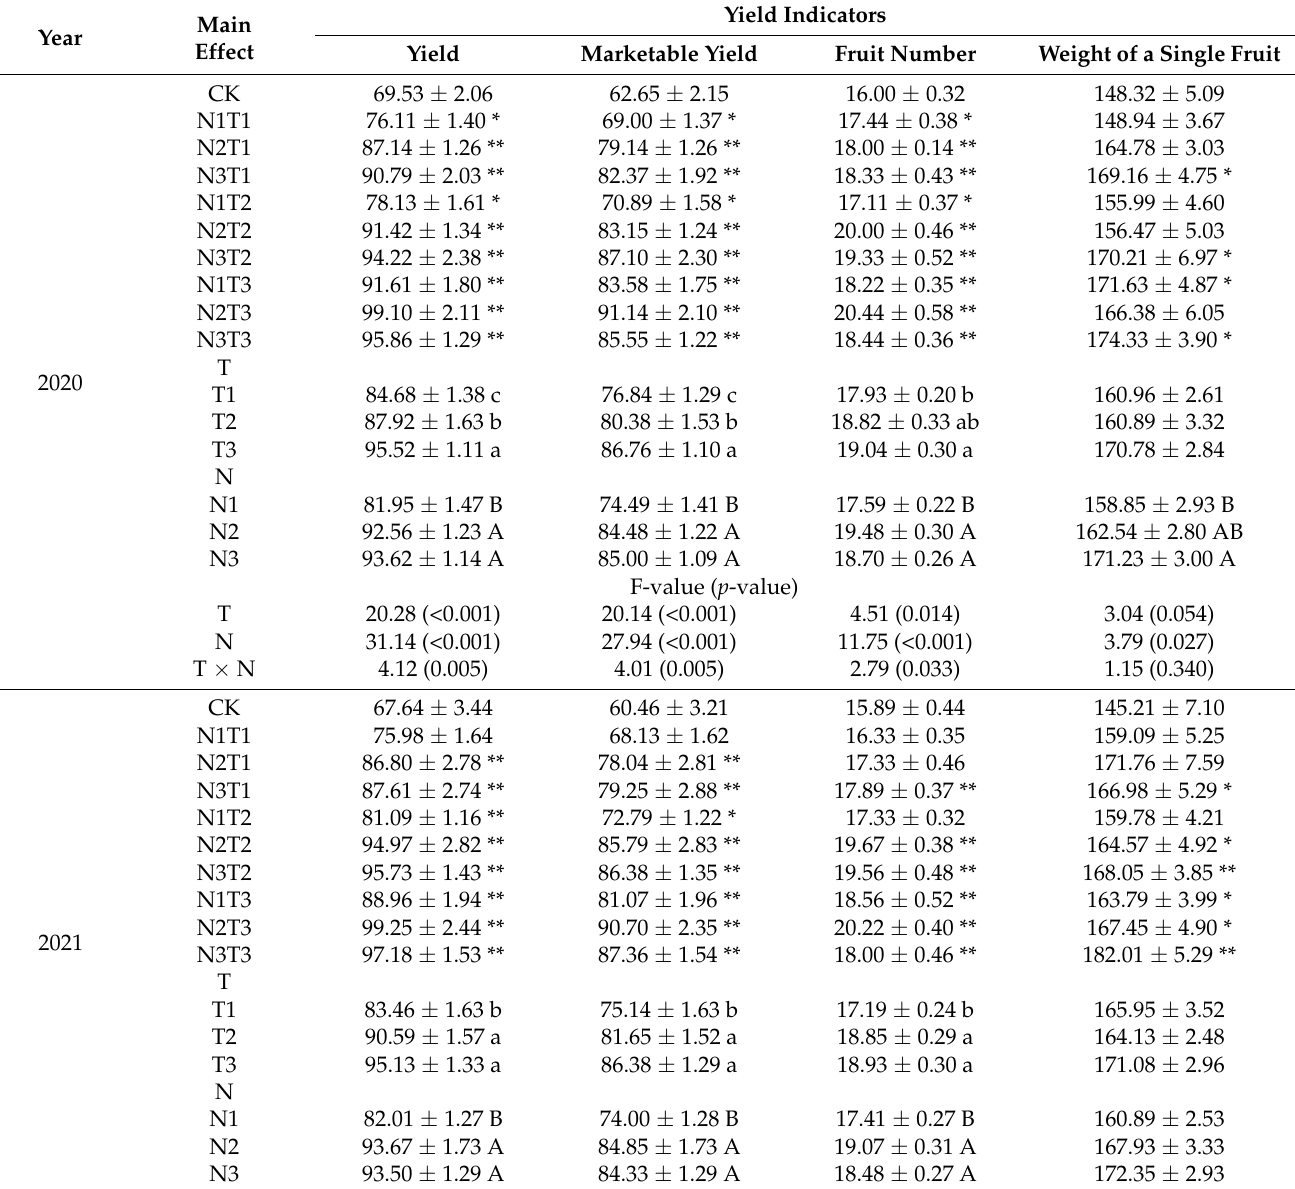
Table 9. Response of tomato yield (Y, t · ha − 1 ), marketable yield (Y m , t · ha − 1 ), number of fruits (plant − 1 ), and weight of a single fruit (g) to different urea types and N application rates in the